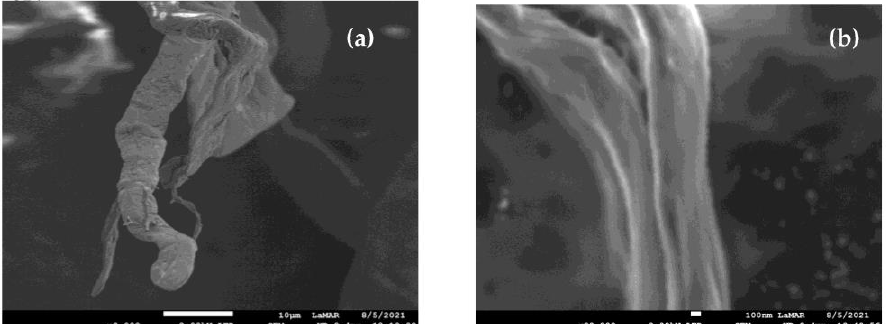
Figure 3. SEM micrographs obtained at the magnification levels of: ( a ) KCP at 2,000× And ( b ) CNF sample No. 7 at 30,000×.